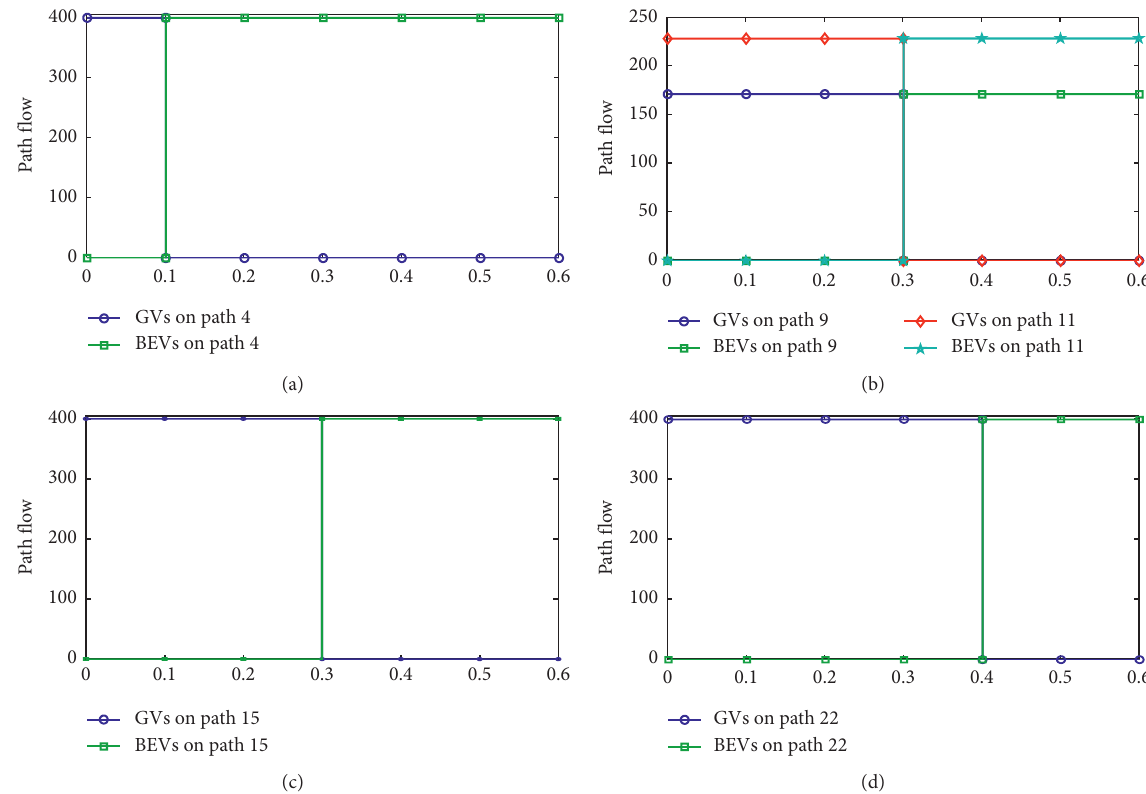
Figure 9: Changing λ a of GVs in Nguyen–Dupuis’ network. (a) O-D pair (1, 2). (b) O-D pair (1, 3). (c) O-D pair (4, 2). (d) O-D pair (4, 3).